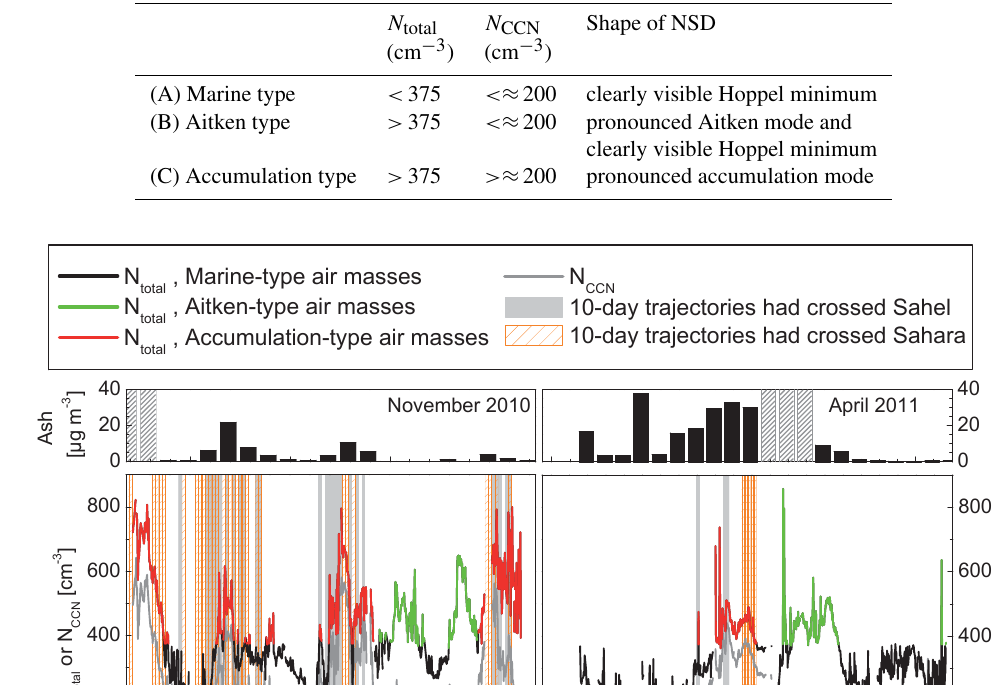
Table 2. Overview over the three observed distinct aerosol types. Typical NSDs are shown in Fig. 1.